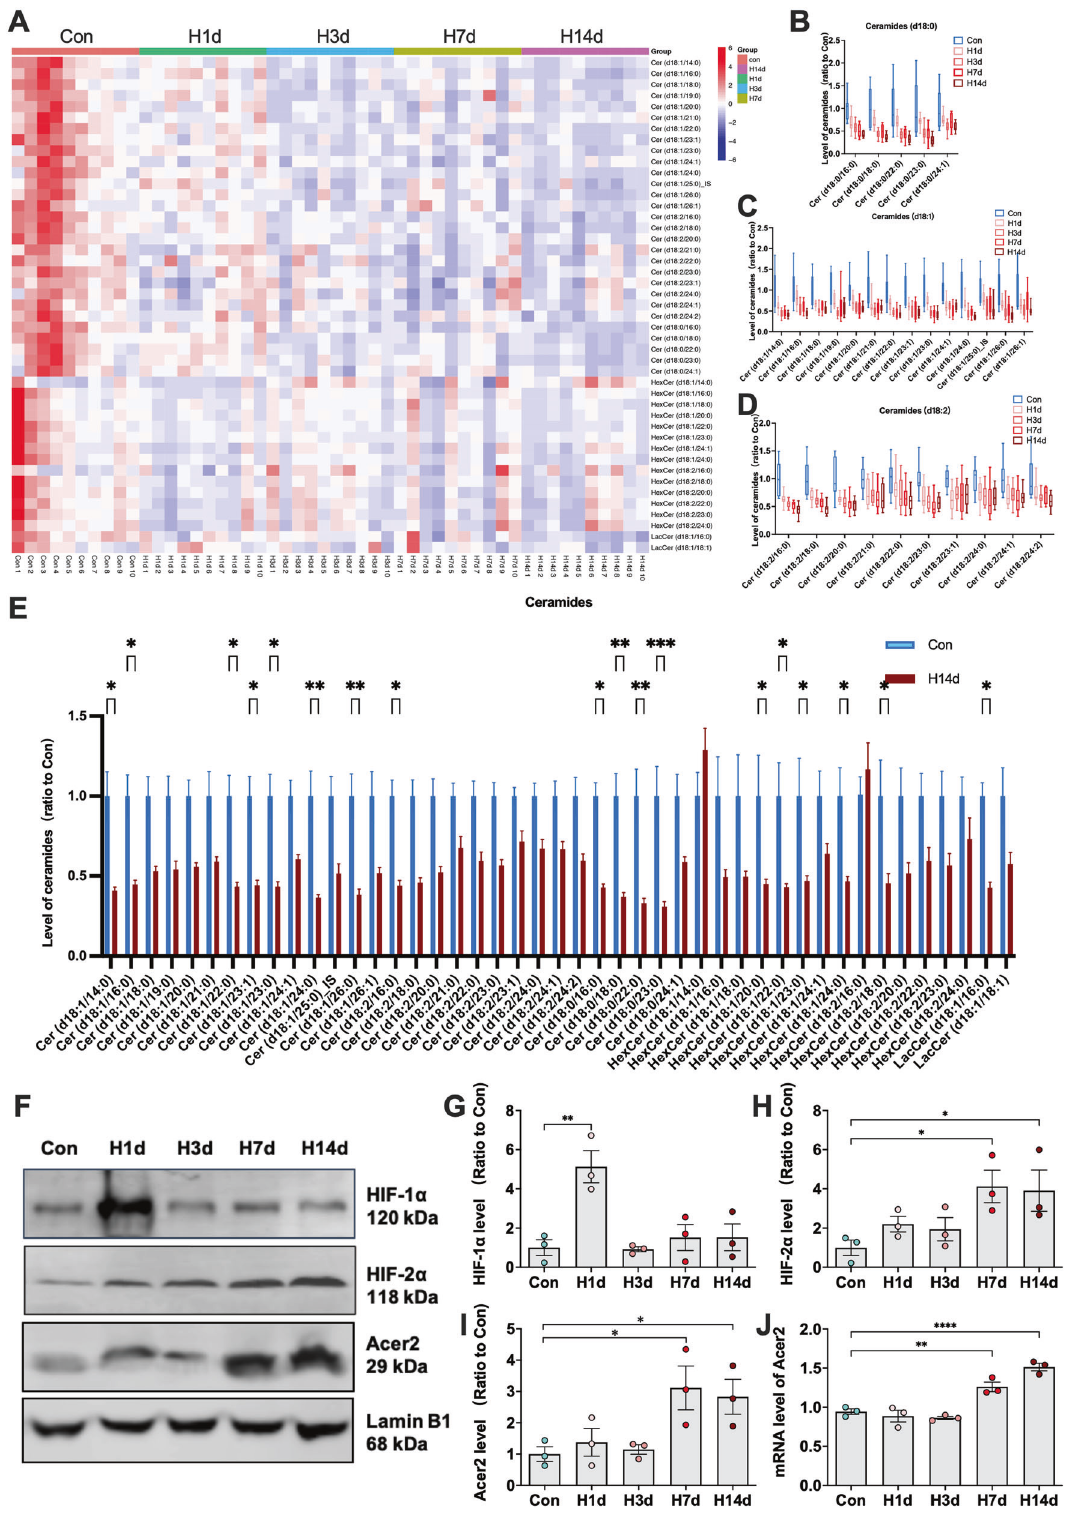
Fig. 6 Chronic hypoxia promotes ceramide hydrolytic metabolism by activating the HIF-2 α /Acer2 signaling pathway, thereby downregulating PP2A activity. A – E Metabolomics of ceramides in the hippocampal tissue of mice with hypoxia for different periods (Con, H1d, H3d, H7d, H14d); heat map and statistical analysis of different subtypes of ceramides in each group. F – I The levels of HIF-1 α , HIF-2 α , and Acer2 in the nuclei of the hippocampi of mice of different hypoxic time groups (Con, H1d, H3d, H7d, H14d) were detected by western blots with β -actin as the internal reference; Statistical analysis was performed. J The mRNA levels of Acer2 in the hippocampi in each group were detected by RT-PCR and statistically analyzed. In B – E , data are expressed as the mean ± SEM (two-way ANOVA), * P < 0.05, ** P < 0.01, *** P < 0.001, n = 10. In G – J , data are expressed as the mean ± SEM (one-way ANOVA), * P < 0.05, ** P < 0.01, **** P < 0.0001, n =